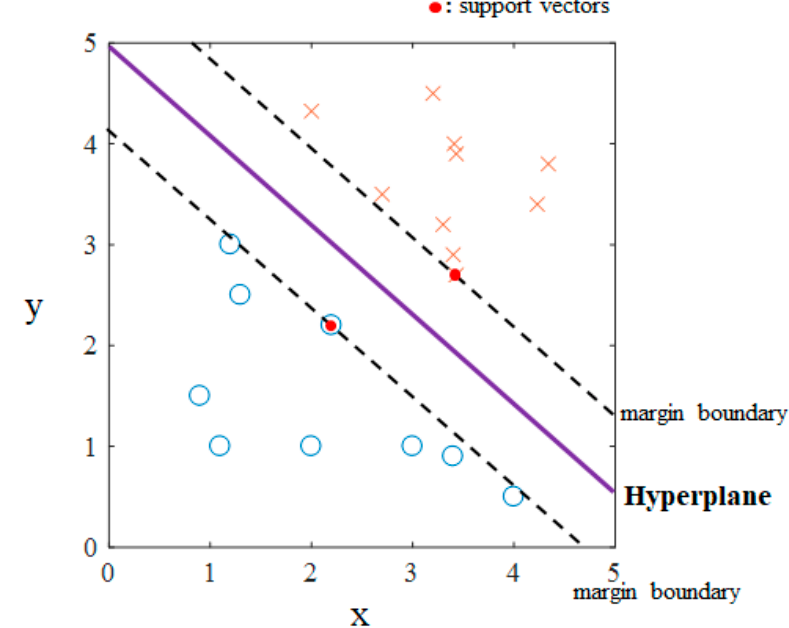
Figure2. Exampleoflinearsupportvectormachinebinaryclassificationintwodimensions. Thesymbols Figure 2. Example of linear support vector machine binary classification in two dimensions. The ‘O’ and ‘X’ represent the data in each symbols ‘O’ and ‘X’ represent the data in each class.